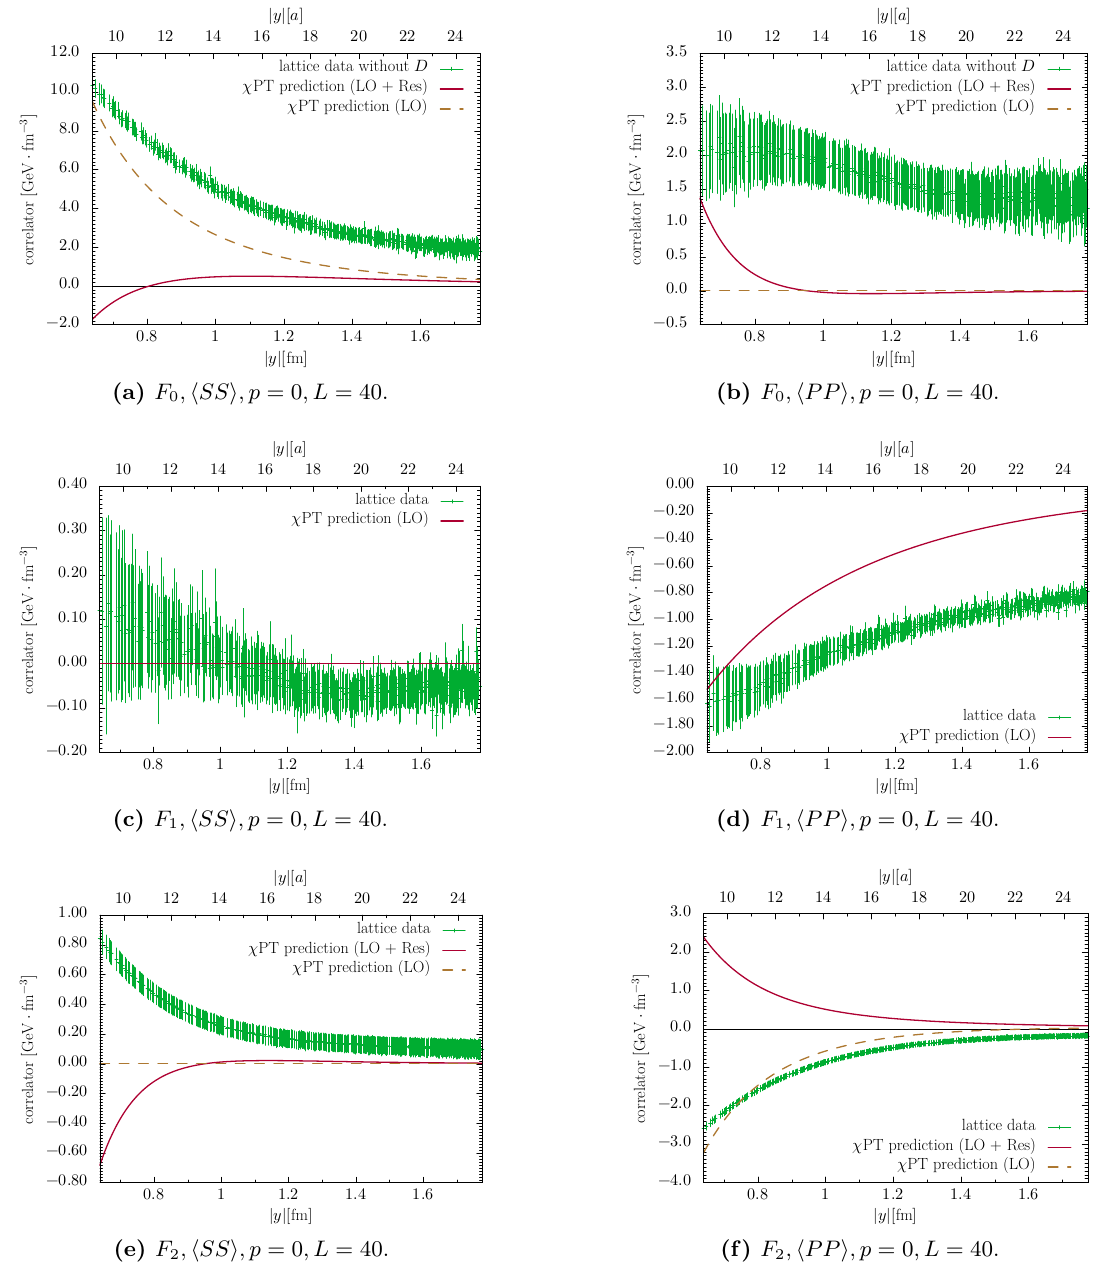
Figure 24. As (cid:12)gure 23 but for the correlators bution is zero for